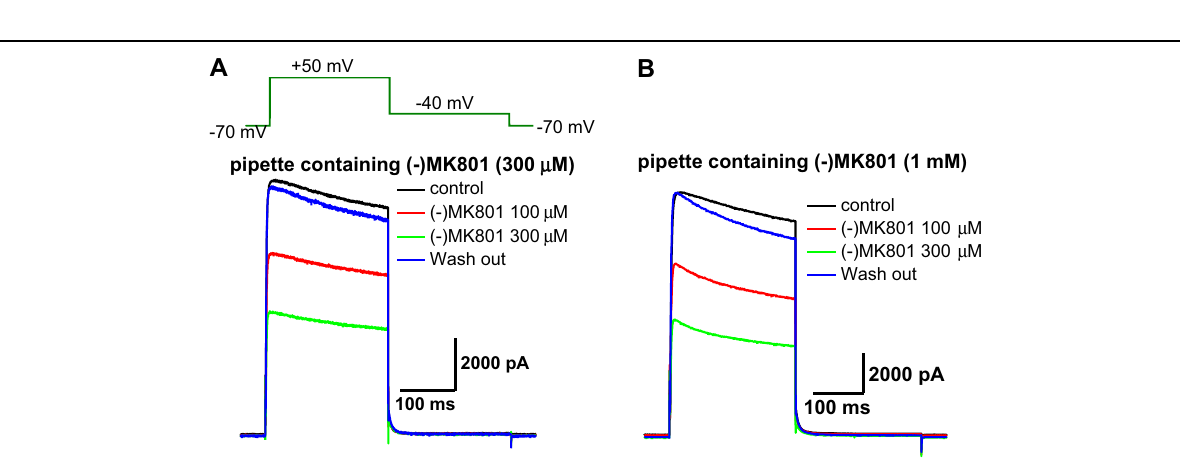
Fig. 3 Inhibition of Kv1.5 currents by extracellular MK801 recorded with MK801-containing pipettes. a Representative Kv1.5 current tracings elicited by voltage steps shown in the fi gure inset with the pipette containing 300 µM MK801 in the absence and presence of various concentrations of MK801 in the bath. b Representative Kv1.5 current tracings with the pipette containing 1 mM MK801 in the absence and presence of various concentrations of MK801 in the bath. Similar results from 3 further independent